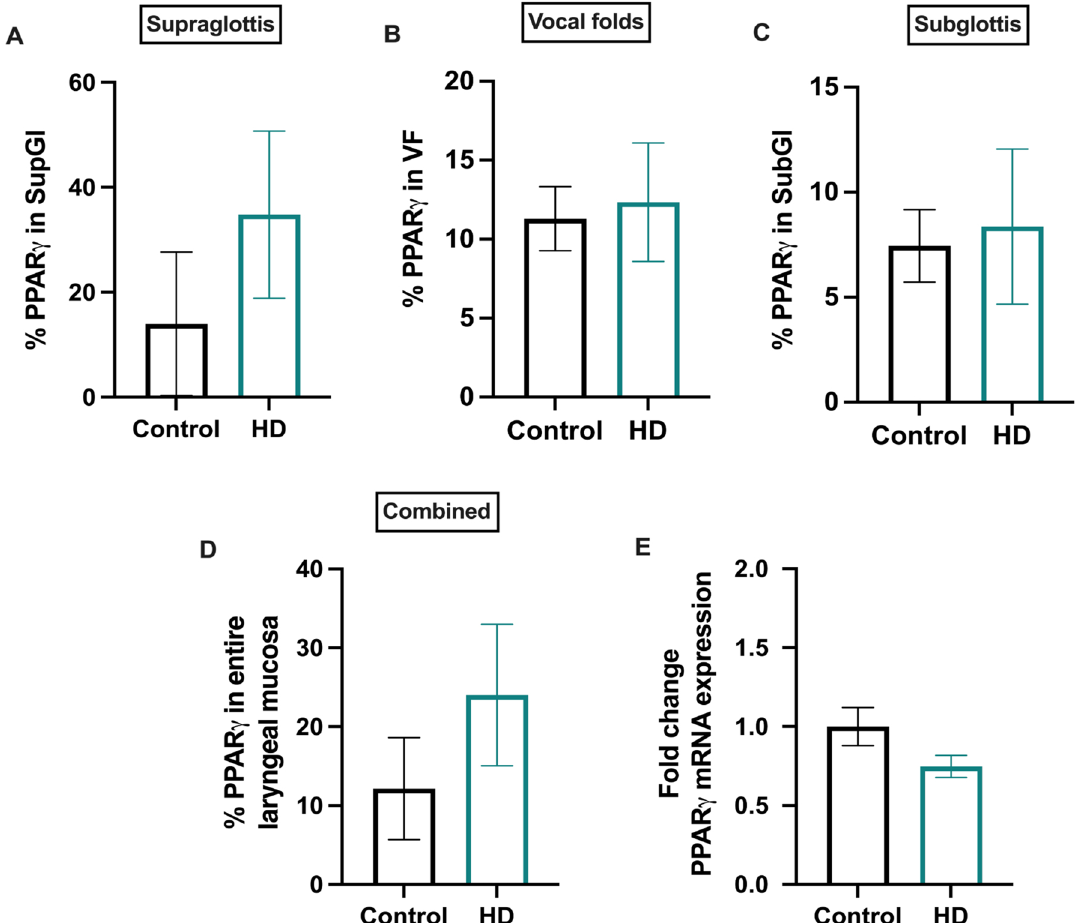
Figure 6. Quantification of PPARγ in the laryngeal mucosa. Immunohistochemical evaluations revealed that PPARγ expression levels remained non-significant in the HD group in comparison to the control group in supraglottis ( A ), vocal folds ( B ), subglottis ( C ), and when averaged across entire laryngeal mucosa including the aforementioned regions ( D ). mRNA expression levels of PPARγ were also unaltered between HD and control groups ( E ). Gene expression was normalized to the reference gene, Gusb. Bar plots are represented as mean with